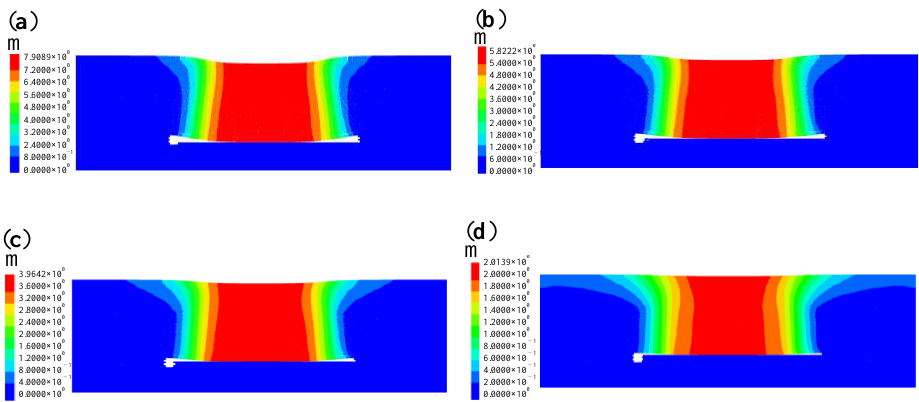
Figure 5. ( a ) Displacement nephogram with the filling rate of 20%. ( b ) Displacement nephogram with filling rate of 40%. ( c ) Displacement nephogram with the filling rate of 60%. ( d ) Displacement nephogram with a filling rate of 80%.